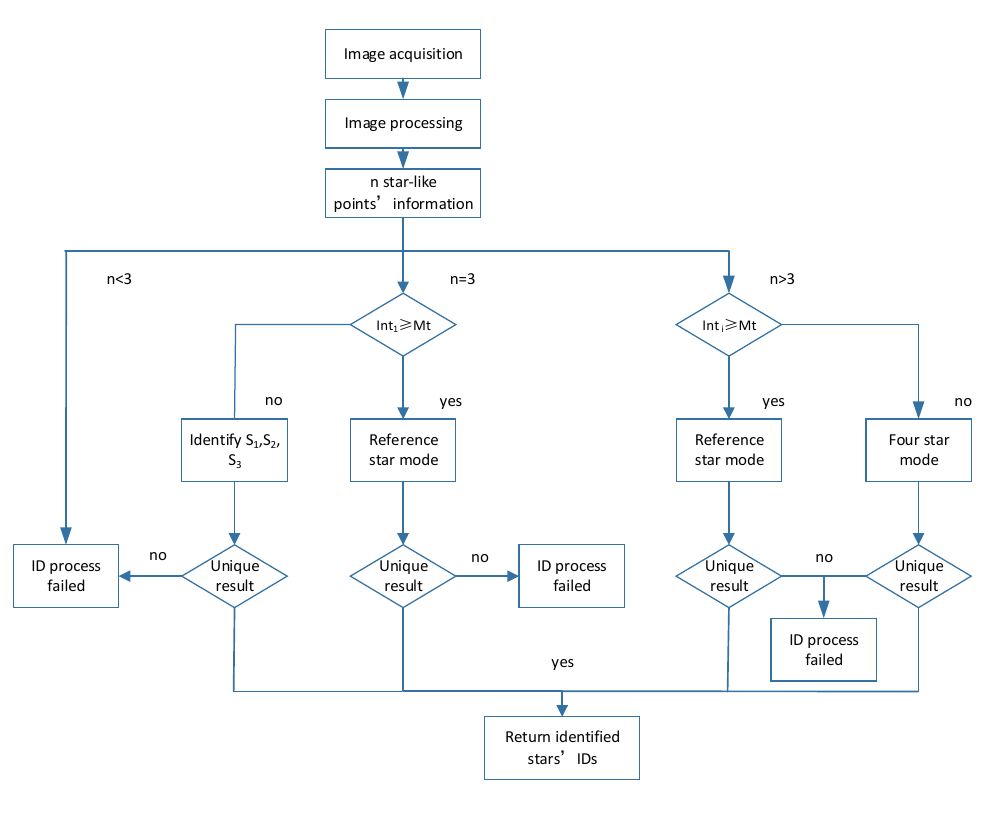
Figure 6. Flowchart of the brightness referenced ID